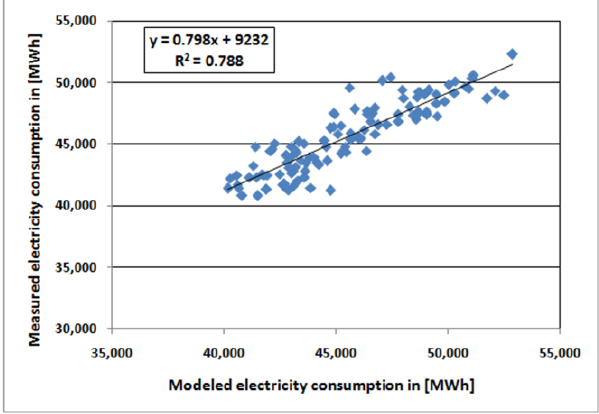
ffi cient with linear Figure 4. R square coefficient with linear regression. Figure 4. R square coe